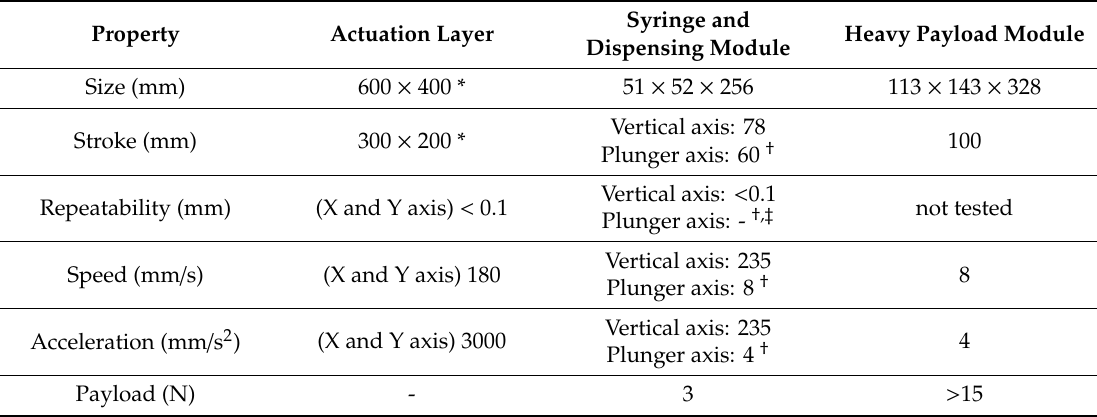
Table 1. Performance characteristics of the actuation layer and